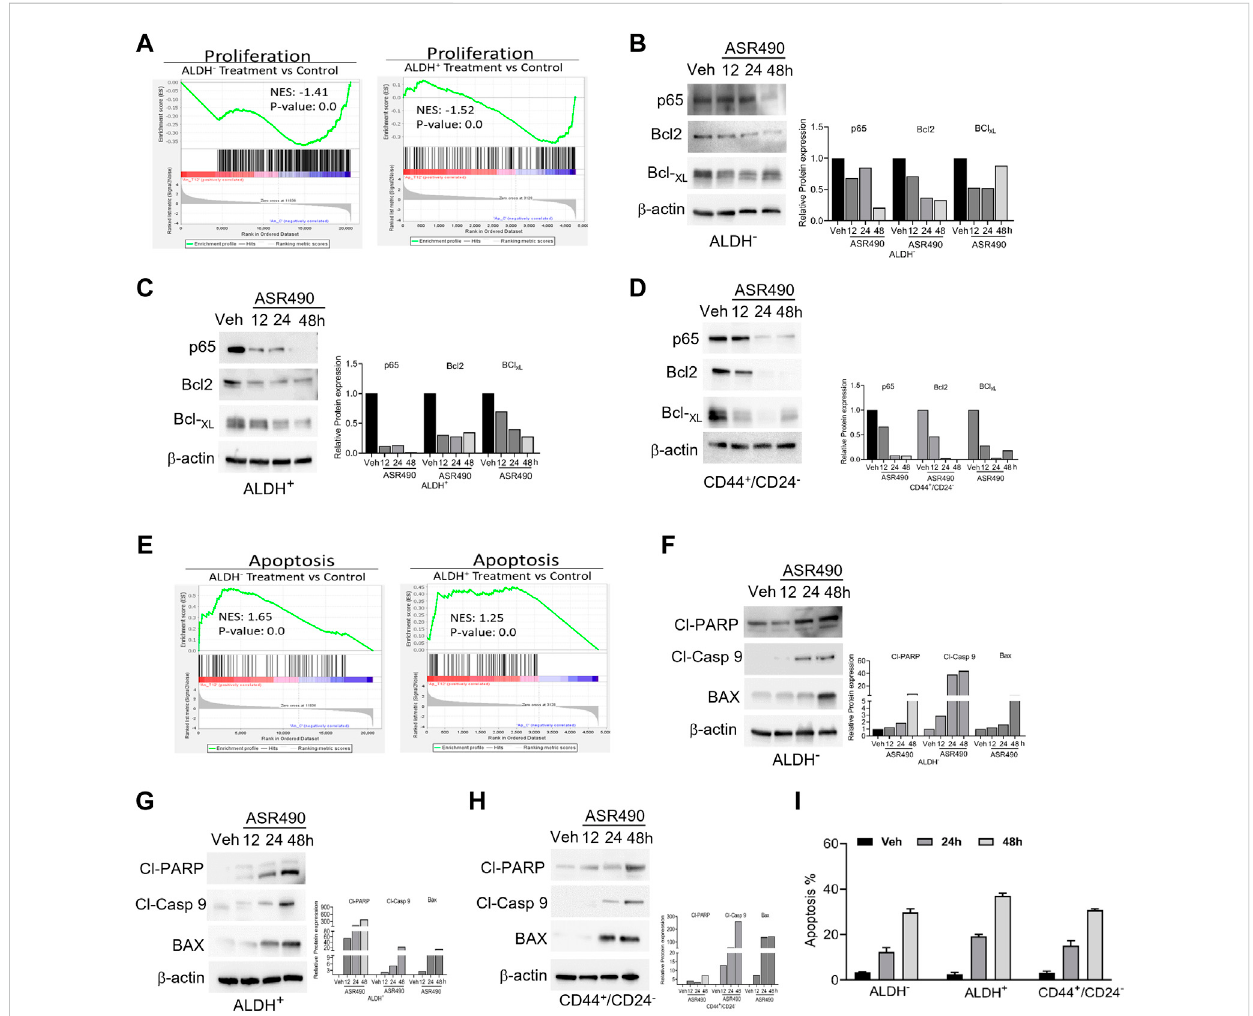
FIGURE 8 ASR490 inhibits the pro-survival signaling of BCSCs. (A) GSEA of RNA-seq data demonstrating alterations in proliferation signaling pathways in ASR490-treated ALDH − and ALDH + cells. (B – D) Westernblots showing time-dependent effects of ASR490 treatment on pro-survival markers NFkB p65, Bcl2, and Bcl- XL expression in ALDH − , ALDH + , and CD44 + /CD24 − cells. (E) GSEA of RNA-seq data demonstrating alterations in proapoptotic signaling in ASR490-treated ALDH − and ALDH + . (F – H) . Western blots showing time-dependent effects of ASR490 treatment on the proapoptotic markers Cleaved-PARP,Cleaved-Caspase9,andBAXinALDH − ,ALDH + ,andCD44 + /CD24 − cells. (I) FACSanalyses(AnnexinV – FITCandPIstaining)performedfor vehicle and ASR490-treated ALDH − , ALDH + , and CD44 + /CD24 −